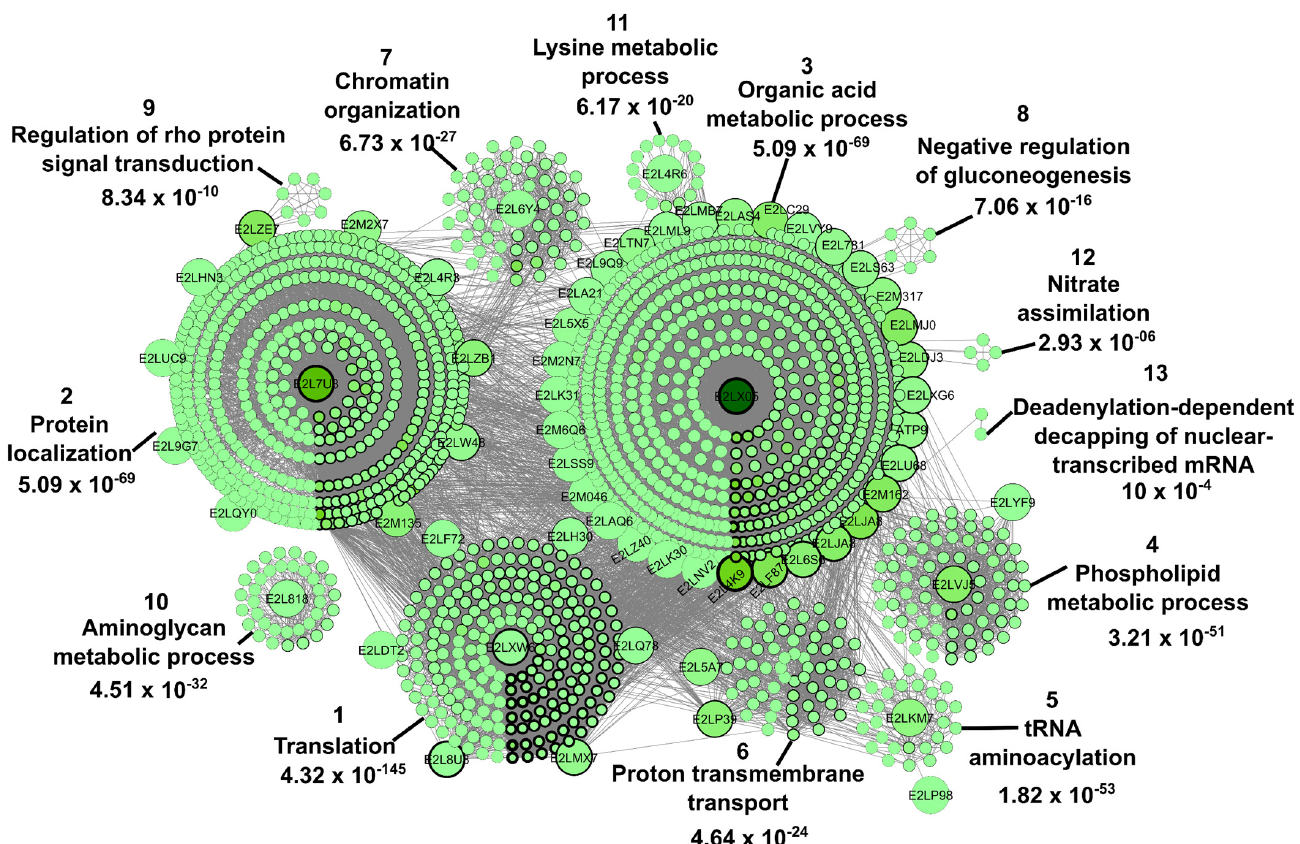
Figure 7. Protein-protein interaction network. Each node represents a protein. The largest nodes represent the proteins from Supplementary Table S6. Each numbered group represents a cluster. with an assigned biological process. The betweenness value is represented by the filling color of the nodes, where the lightest color represents the lowest value and the darkest color the highest value. The node degree parameter is represented by the nodes’ border width, where nodes with a thinner border have a lower node degree and nodes with a wider border have a higher node degree value.